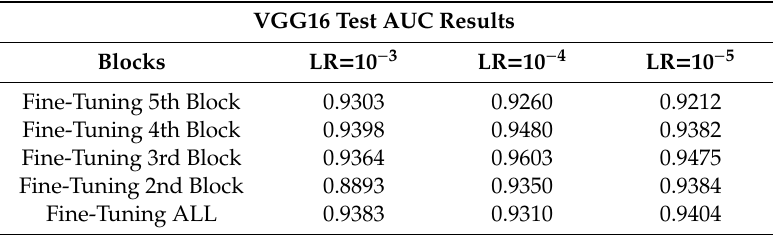
Table 2. Results of the VGG16 architecture.